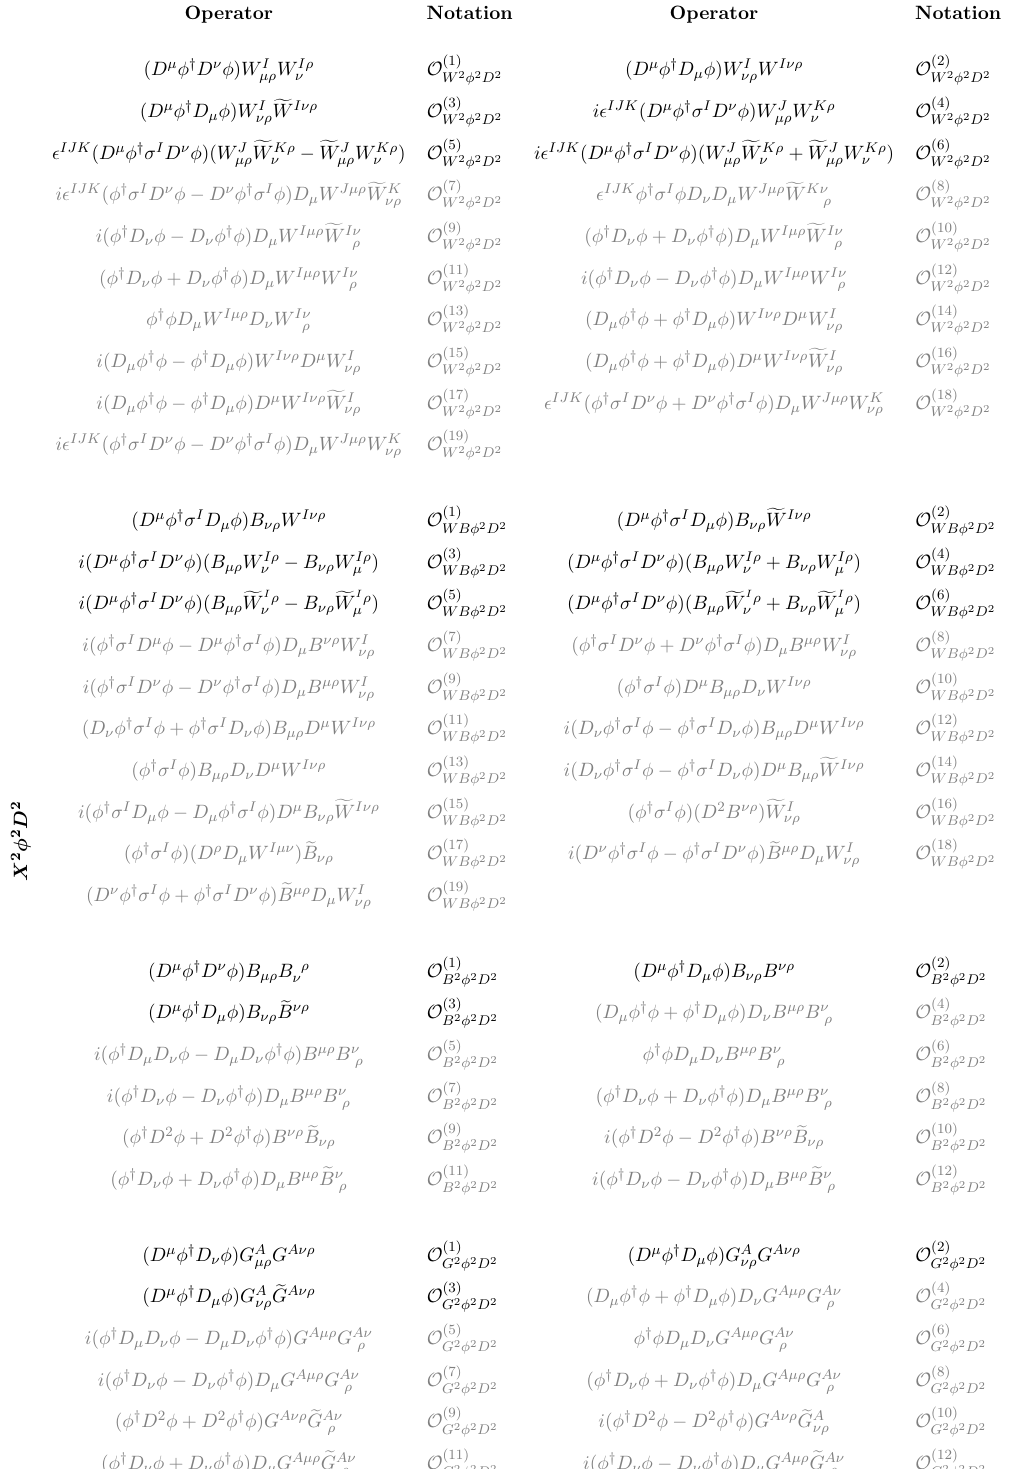
Table 2 . Green’s basis of operators, part